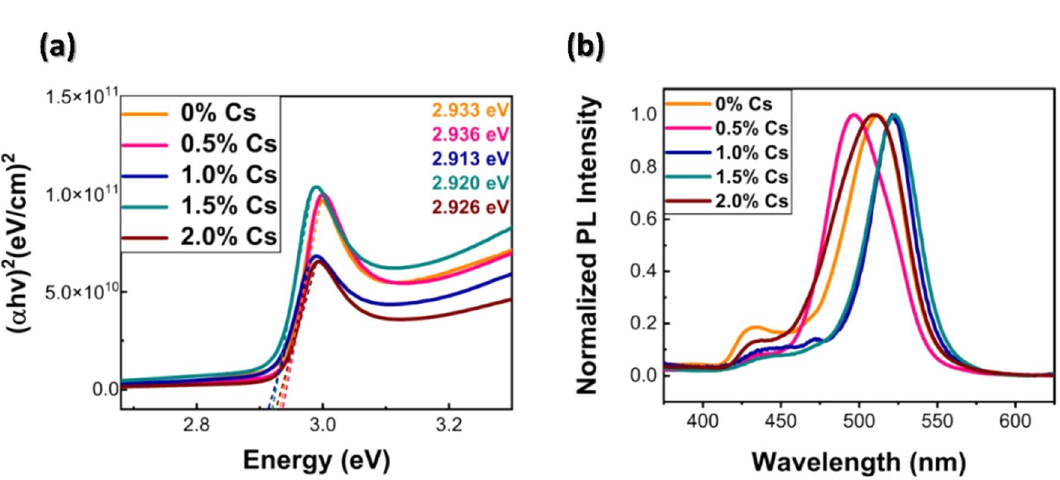
Figure 3. ( a ) Tauc Plot for optical bandgap (E g ) analysis, and ( b ) PL Spectra of 0.8 M (PEA) 2 (Cs x MA 0.61-x FA 0.39